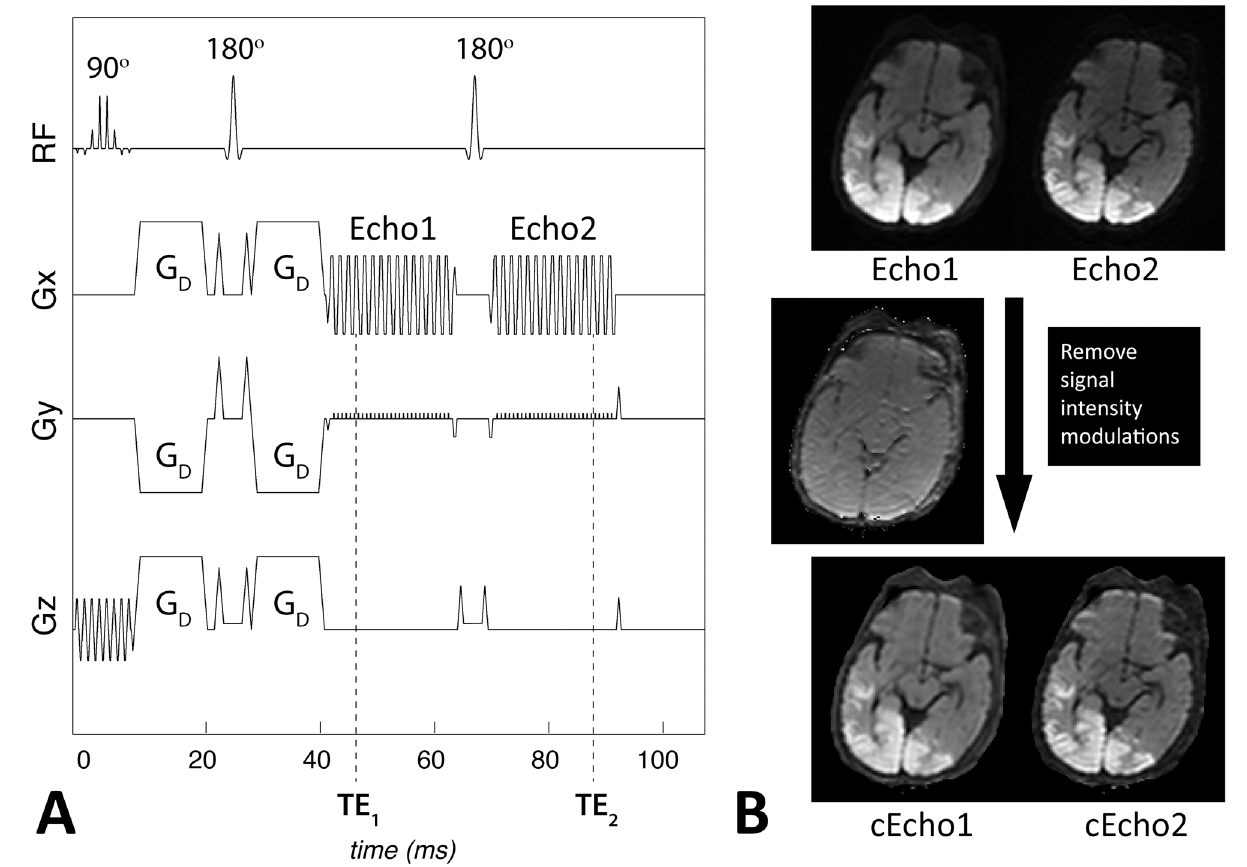
Fig 1. A. Our 1minute dual-echo Echo-Planar Imaging (DE-EPI) DWI pulse sequence corresponding to the acquisition of one slice, with timing and relative gradient and pulse amplitudes drawn approximately to scale. The diffusion (tetrahedral encoding) diffusion gradients, G D , are shown following slice selection with a 90° spectral spatial radiofrequency (RF) pulse. After the diffusion preparation period, Echo1 is acquired at TE 1 , followed by a 90° refocusing pulse and Echo2 at TE 2 . Note that the total acquisition time for one slice varies from 102 – 108ms depending on the FOV. B. Equivalent coil-sensitivity imprinted on Echo1 and Echo2 (here DWI) images allows one to extract and remove the contribution of receive coil and RF sensitivity, B0 susceptibility differences, T1, and proton density to the signal. Note that the resulting intensity-corrected images (cEcho1 and cEcho2) resemble that of an exponential ADC image with added T2 contrast. Data is acquired on a 9day old male infant with diffusion abnormality associated with hypoglycemia.